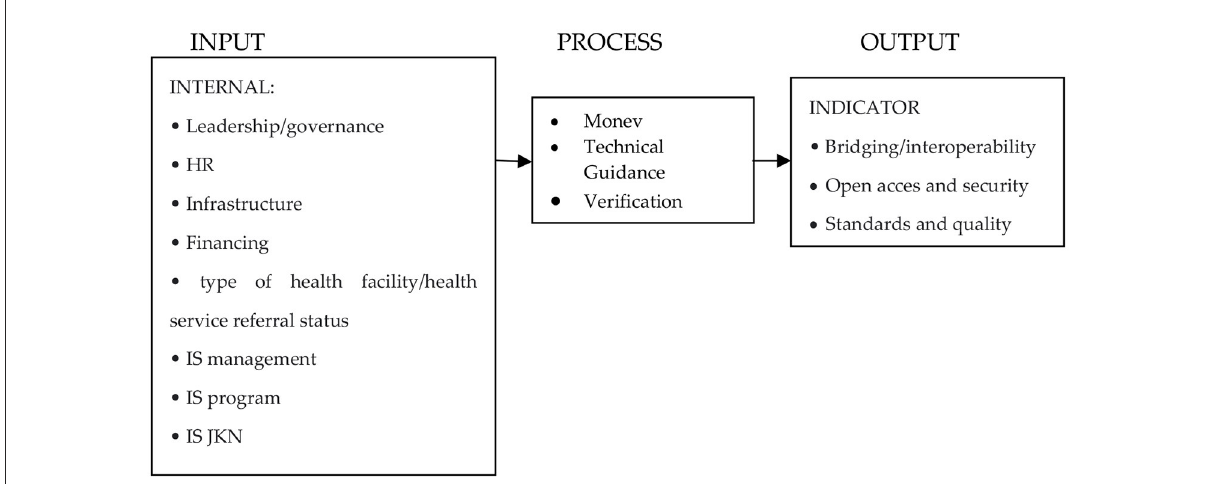
FIGURE1 General form of structural equation modeling of the health information system in health services in the implementation of JKN in